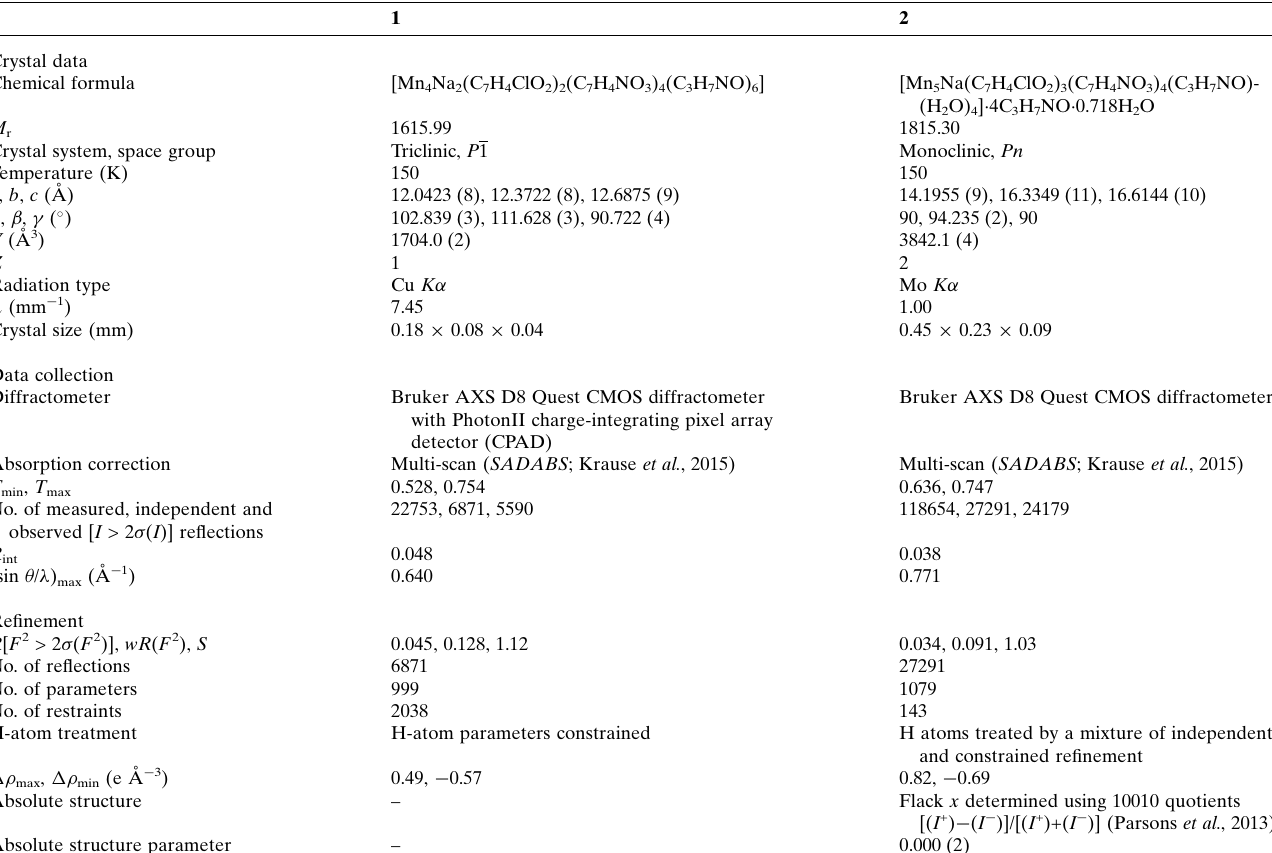
Table 10 Experimental details.